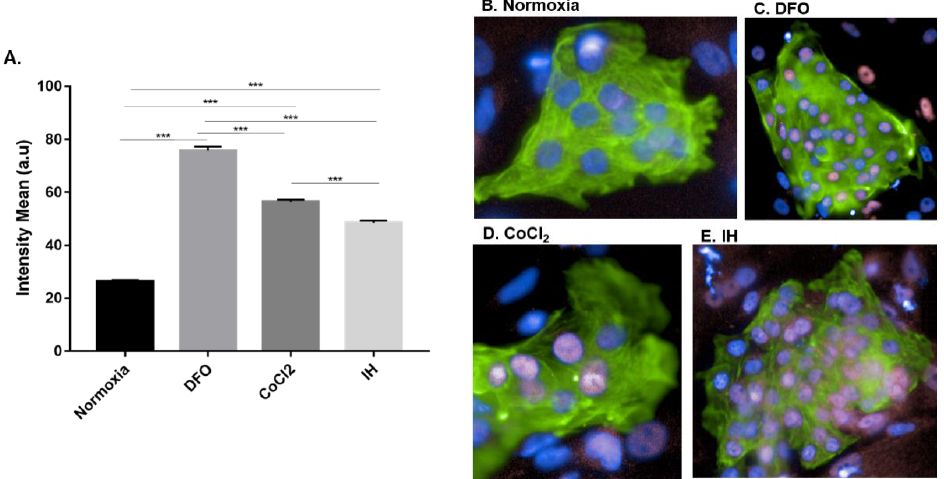
Figure 1. Increase in nuclear Hif-1 α expression in hESC-CMs following IH: ( A ) quantification of the hypoxia marker Hif-1 α expression in the nucleus following normoxia or IH only on CMs; normoxia = normal conditions (21% O 2 , 37 ◦ C), DFO and CoCl 2 were incubated in normal conditions as well; IH = intermittent hypoxia (1% O 2 , 37 ◦ C) for 12 h (60 Cycles). Results are averages of 3 separate experiments performed in 10 replicates, ANOVA analysis *** p < 0.001, n = 37,661; ( B ) immunostaining of Hif-1 α and troponin (cardiomyocytes specific marker) following normoxia or IH. Differentiated CMs were detected with antibodies to troponin, a marker of cardiomyocytes cells (green) and Hif-1 α (pink), followed by the appropriate secondary antibody. Nuclei were stained with DAPI (blue); ( B ) normoxia conditions; ( C ) normoxia conditions and DFO; ( D ) normoxia conditions and CoCl 2; and ( E ) IH conditions; 40 × magnification.